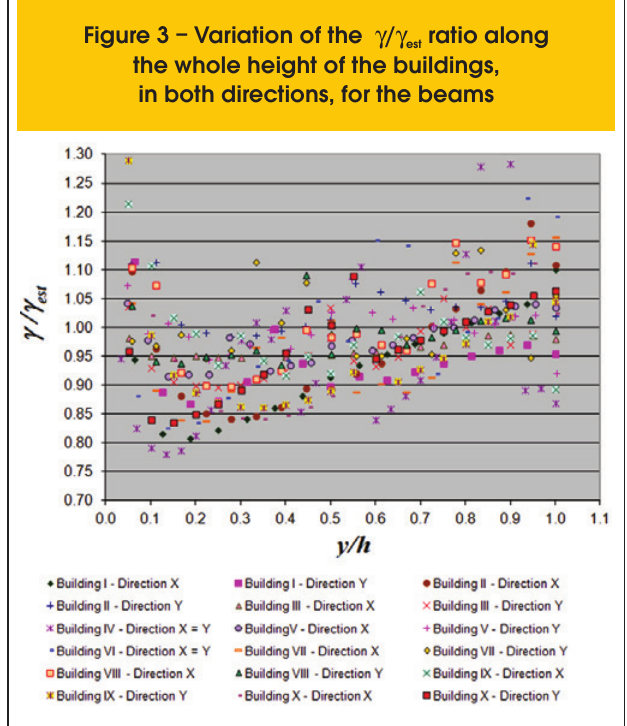
Figure 3 – Variation of the g / g ratio along est the whole height of the buildings, in both directions, for the